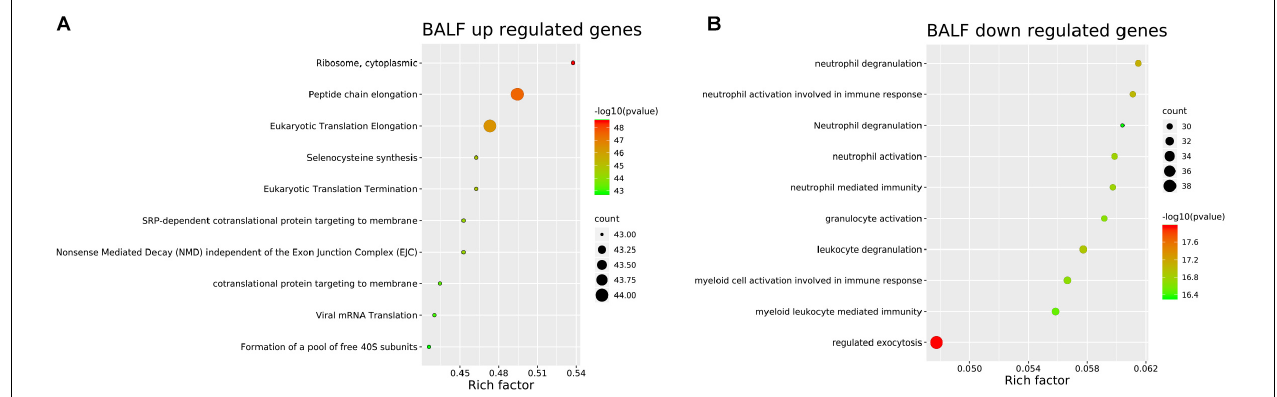
FIGURE 2 | Pathway and process enrichment of DEGs in BALF of COVID-19 patients. (A) BALF up-regulated genes. (B) BALF down-regulated genes. The colors of the nodes are illustrated from red to green in descending order of -Log10 ( p Value). The sizes of the nodes are illustrated from small to big in ascending order of gene counts. The horizontal axis represents the rich factor, the vertical axis represents the GO or KEGG terms.